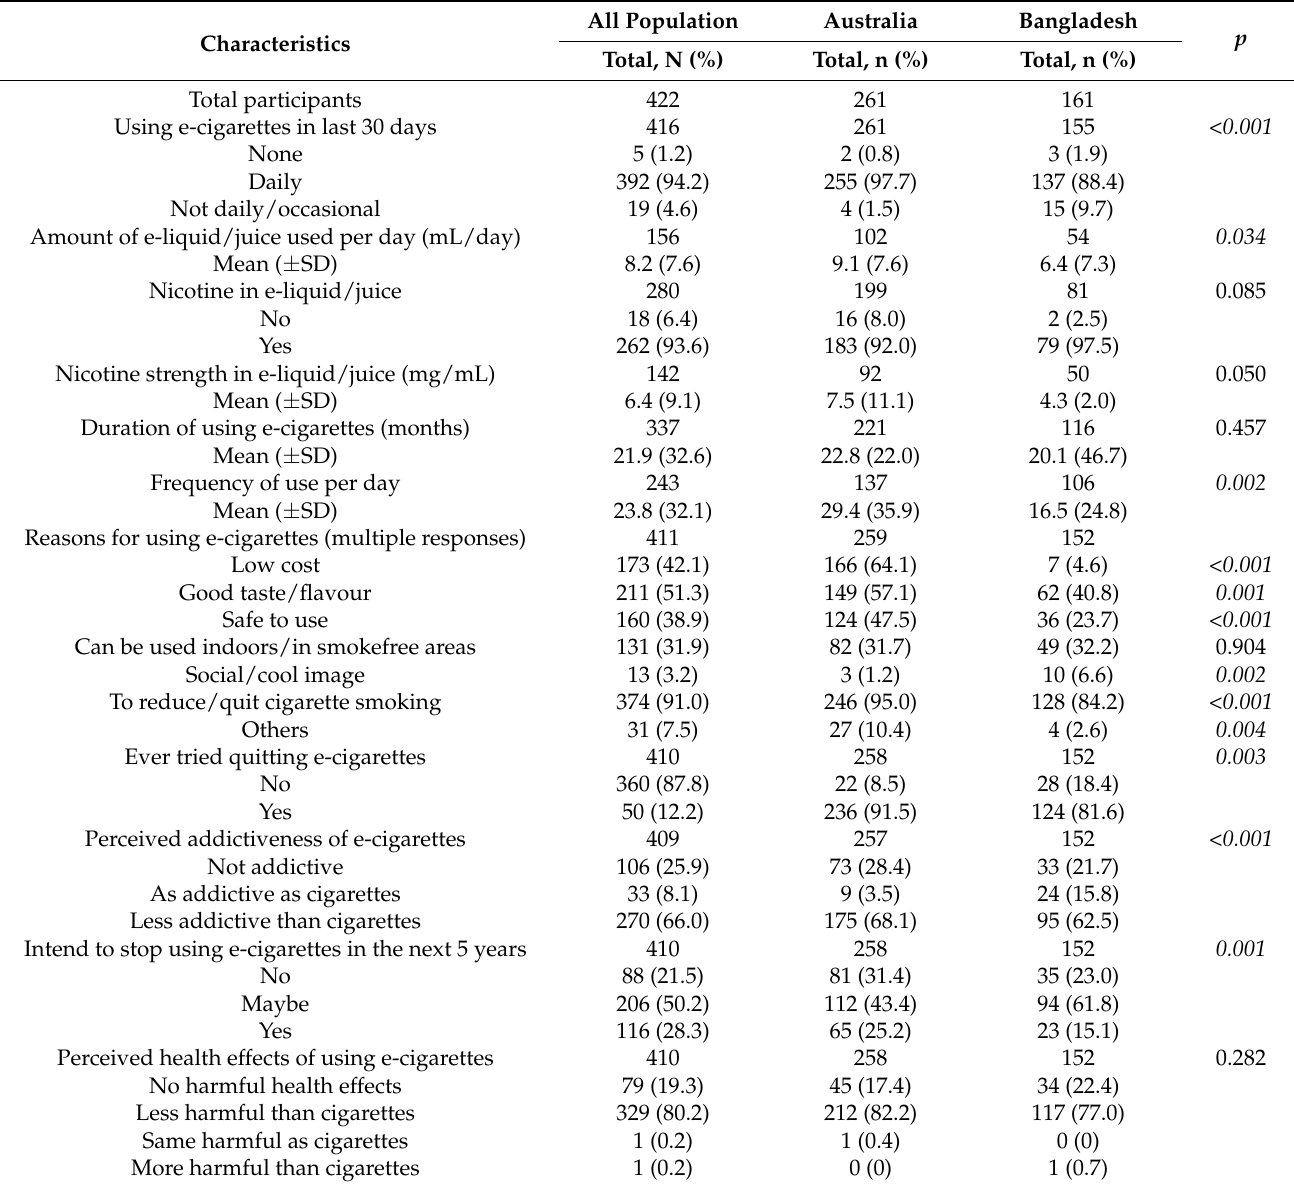
Table 3. Use of electronic cigarettes or vaping among the study